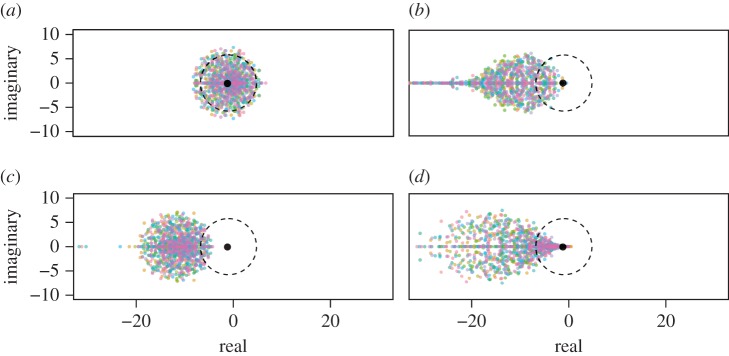
Distribution of eigenvalues for communities with density-dependence variation. Differently coloured points represent the eigenvalues of 10 random community matrices. (a) The case of an equal density dependence (such that both beneficial interactions βij and harmful interactions δij are derived from U(−0.2, 0.2)). (b) βij = U(−1.0, 0.0) and δij = U(−0.3, 0.1). (c) βij = U(−0.4, 0.0) and δij = U(0.0, 0.4). (d) βij = U(−0.1, 0.3) and δij = U(0.0, 1.0). The dashed ellipses represent predictions based on May's stability criterion. Other parameters: N = 100, C = 1.0, smax = 2.0, Xmax = 2.0, bmax = 1.0 and dmax = 1.0.